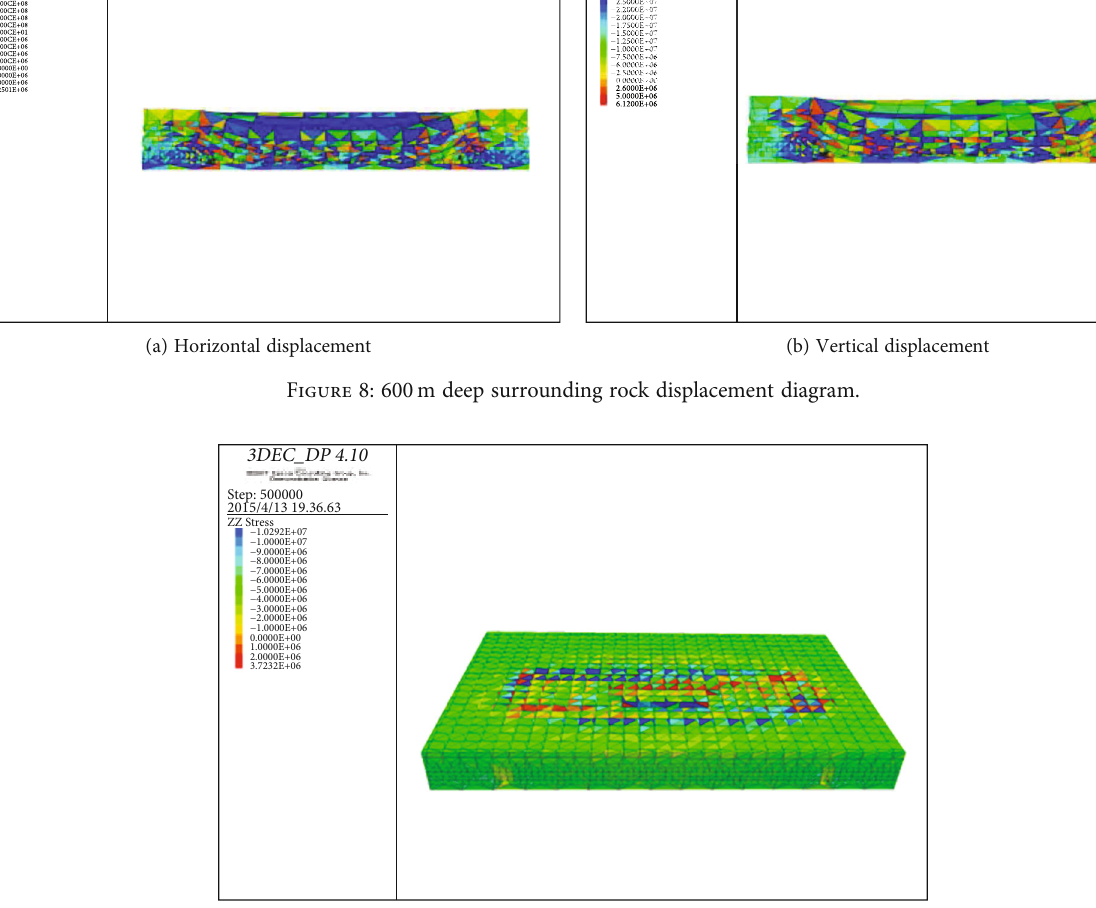
Figure 9: Vertical stress diagram of primary rupture of main roof at 20m mining